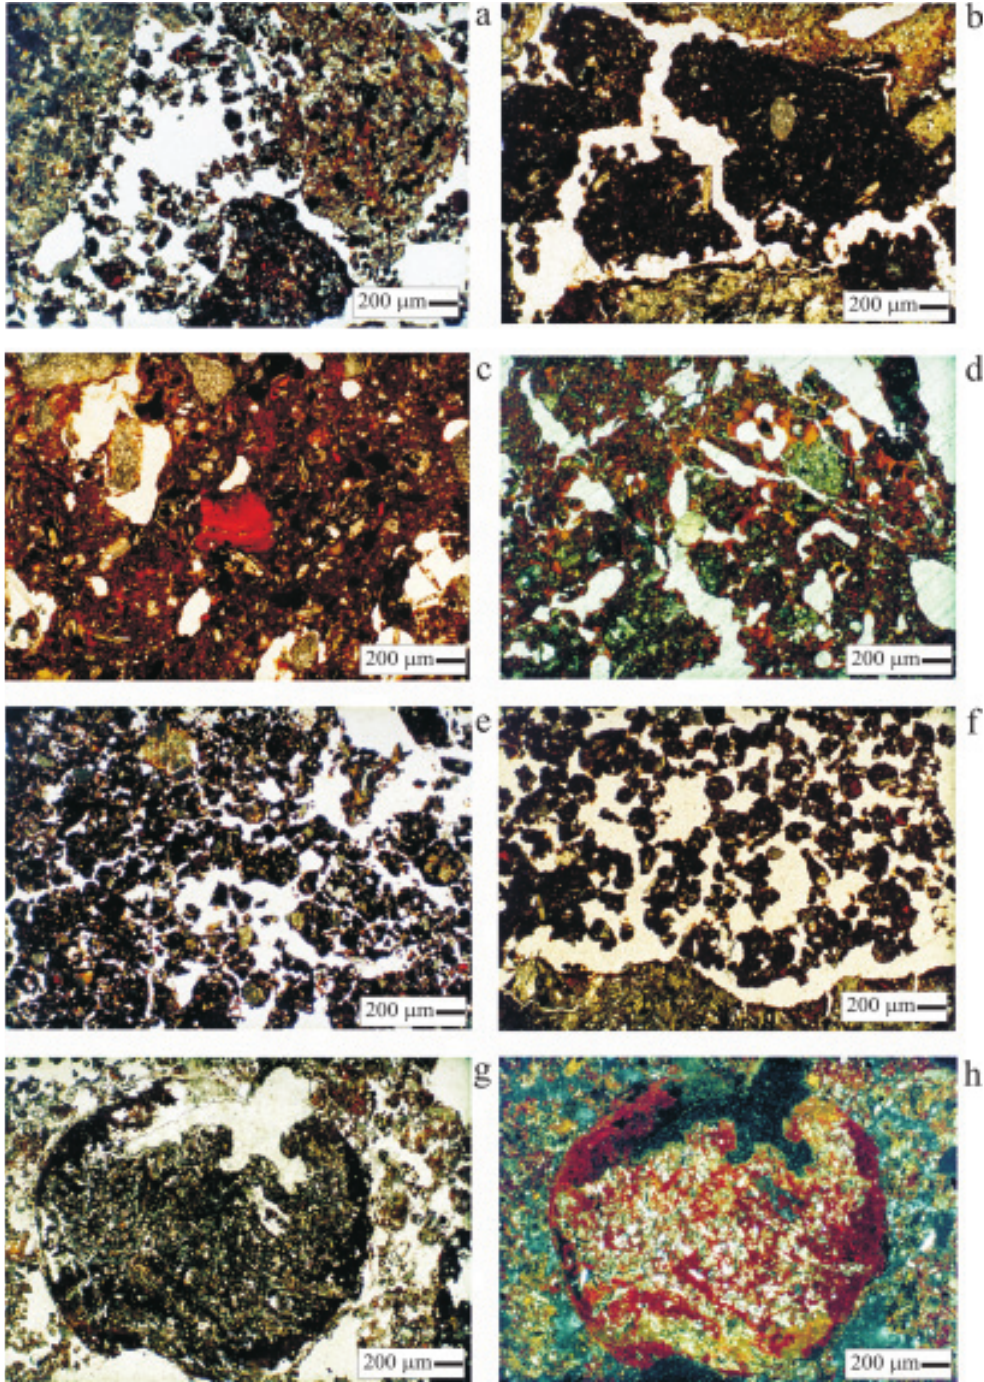
Figura 4. Fotomicrografias selecionadas de seções delgadas dos horizontes Bi dos três perfis estudados. Foto h sob luz polarizada cruzada; demais fotos sob luz polarizada plana. Fotos a e b: trama frágmica inicial formada a partir da evolução da alteração da rocha; Foto c: trama pofírica com cavidades dominantes na maior parte dos agregados estudados nos três perfis. Note-se ao centro pápula de argiluviação incorporada à matriz; Foto d: trama porfírica aberta por coalescência de cavidades que ocorre nas partes mais evoluídas dos agregados; Foto e: microagregação originada por mecanismos de dissolução; Foto f: microagregação do plasma de origem biológica; Fotos g e h: Agregado ferruginizado com grande quantidade de material de rocha (litorrelíquias) com menor grau de alteração do que o entorno em seu interior (oclusão dos minerais primários) e feições de iluviação primária e alteração